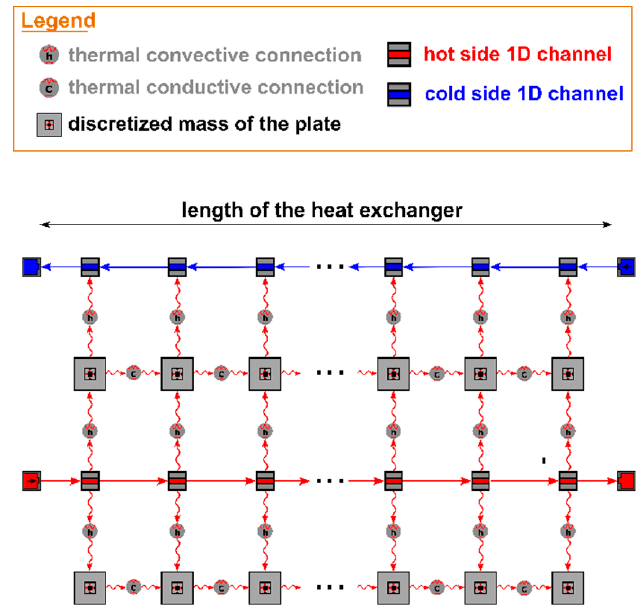
Figure 6. 1D heat transfer network.